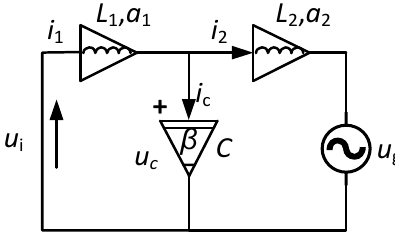
Figure 1. Topology of a fractional-order LCL filter.